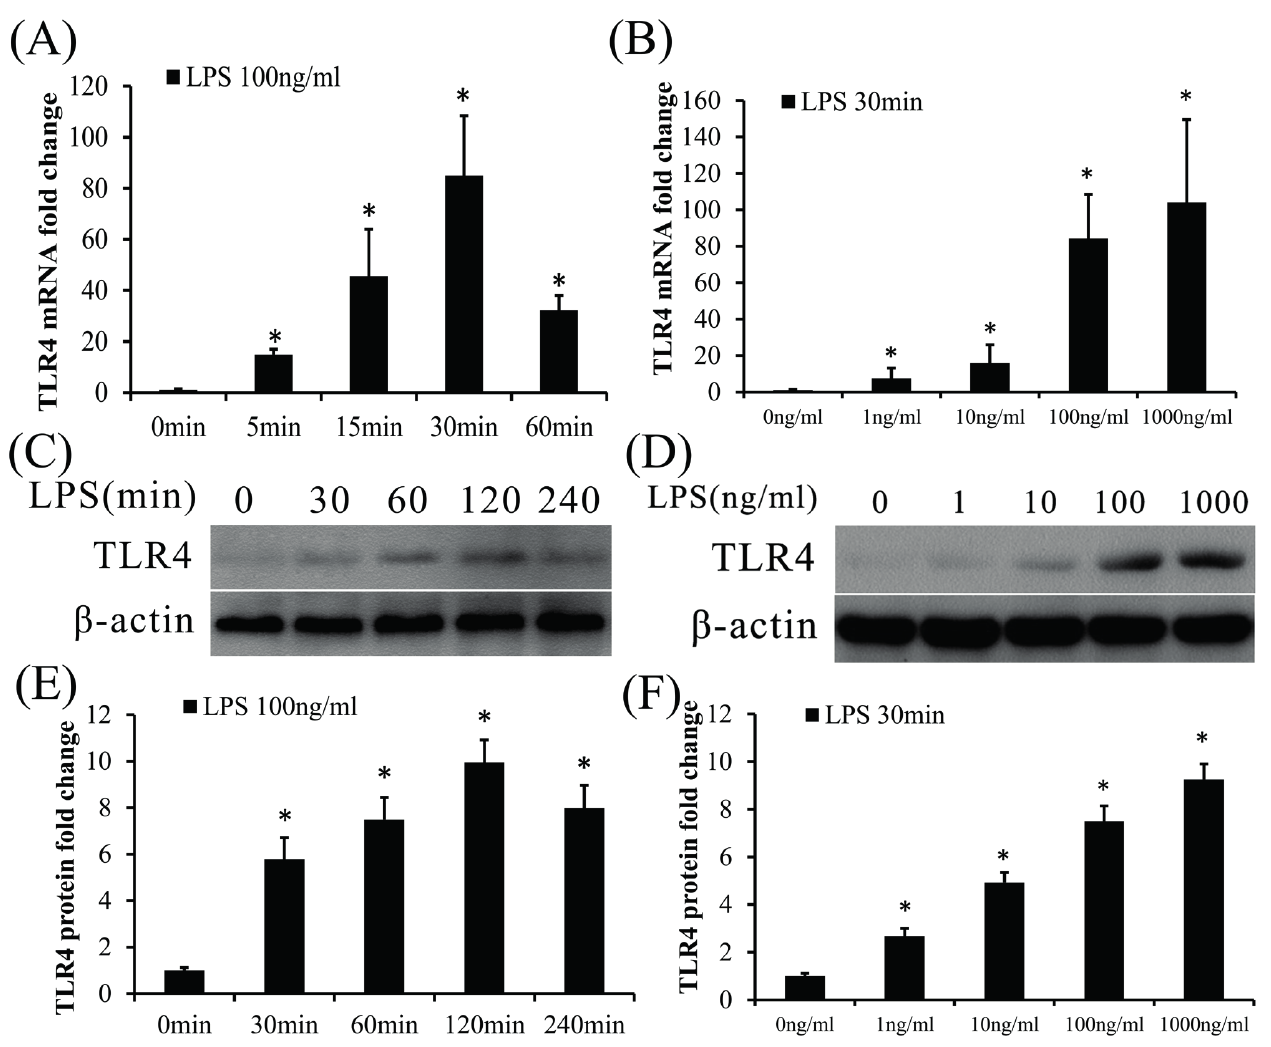
FIGURE 1 - TLR4 mRNA and protein expression in HCAECs after LPS stimulation. (A) Time-ef fect TLR4 mRNA responses of LPS stimulation in HCAECs. Statistical analysis was performed on 5min, 15min, 30min and 60min versus 0min group, respectively. (B) Dose-effect TLR4 mRNA response of LPS stimulation in HCAECs. Statistical analysis was performed on 1ng/mL, 10ng/mL, 100ng/mL and 1000ng/mL versus 0ng/mL group, respectively. (C) Time-effect TLR4 protein response of LPS stimulation in HCAECs. (D) Dose-effect TLR4 protein response of LPS stimulation in HCAECs. (E) Time-effect TLR4 protein expression of TLR4 in HCAECs were quantified by using densitometry, and represented by the ratio of β -actin. Statistical analysis was performed on 5min, 15min, 30min and 60min versus 0min group, respectively. (F) Dose-effect TLR4 protein expression of TLR4 in HCAECs were quantified by using densitometry, and represented by the ratio of β -actin. Statistical analysis was performed on 1ng/mL, 10ng/mL, 100ng/mL and 1000ng/mL versus 0ng/mL group, respectively.*P<0.05 indicates significant